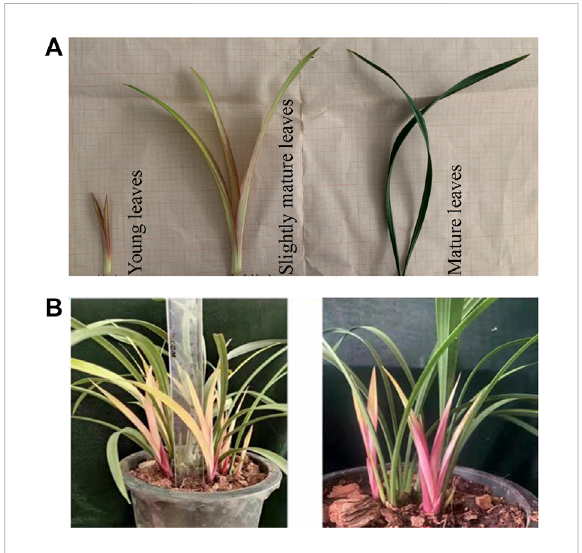
FIGURE 1 A pictorial description of Cymbidium ensifolium leaf coloration. (A) leaf color alteration pertaining to development. (B) leafcolorvariationinmature C.ensifolium leavesdepictingyellow, purple, and green